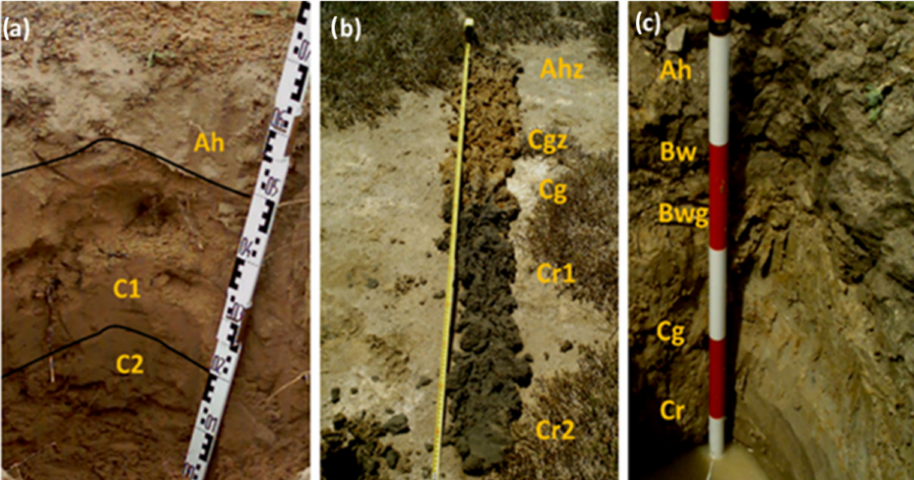
Figure 3. Soil types in the study area. ( a ) Haplic arenosol of the dune ridge. ( b ) Gleyc Solonchak from saline lagoons. ( c ) Gleyc Cambisol from the freshwater